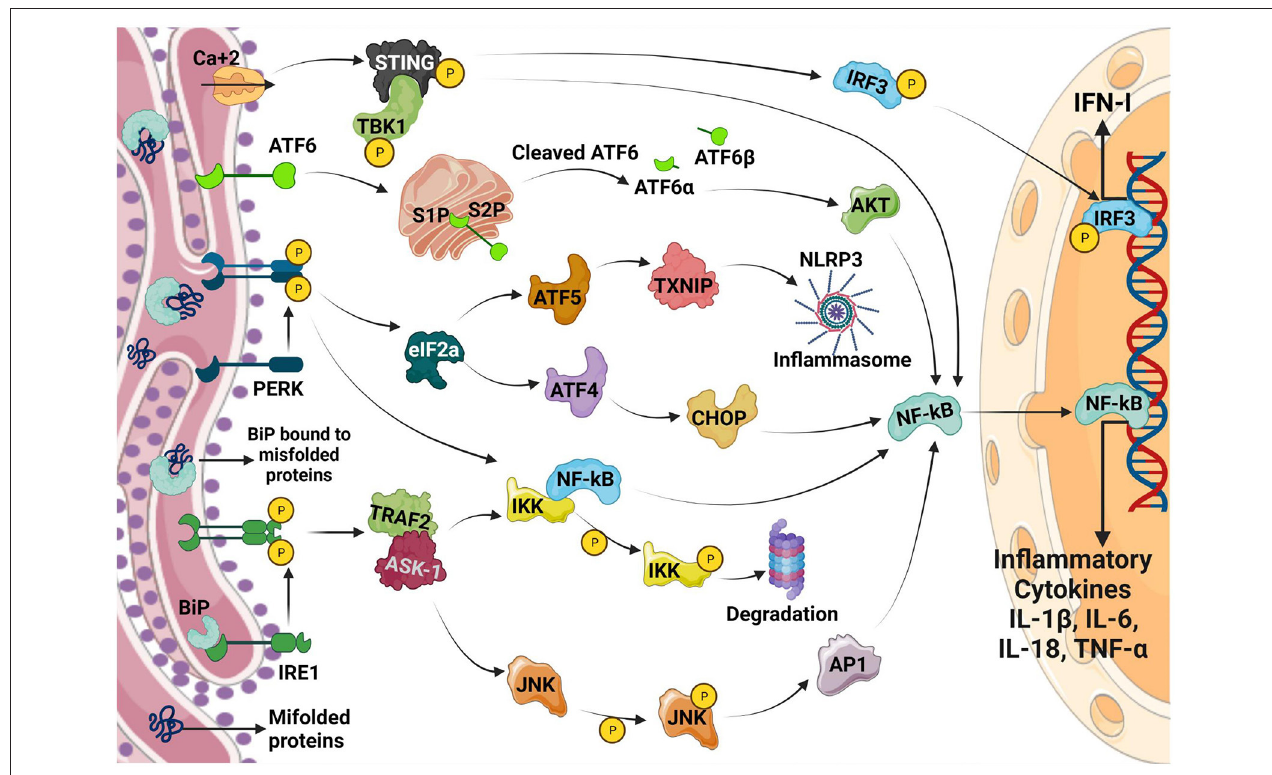
FIGURE 1 | Inflammatory/Cytokine signaling regulated by UPR. Upon ER stress, the ER chaperone BiP dissociates from its complex with IRE1, PERK and ATF6 which results in the activation of the three arms of the UPR pathway as shown in the figure. All the three arms of the UPR regulates the production of inflammatory cytokines via different mechanisms which converge on NF- κ B activation. PERK also regulates TXNIP through the induction of ATF5 which in turn modulates NLRP3 inflammasome resulting in enhanced inflammation. Calcium disruption induced ER stress activates STING pathway resulting in the production of